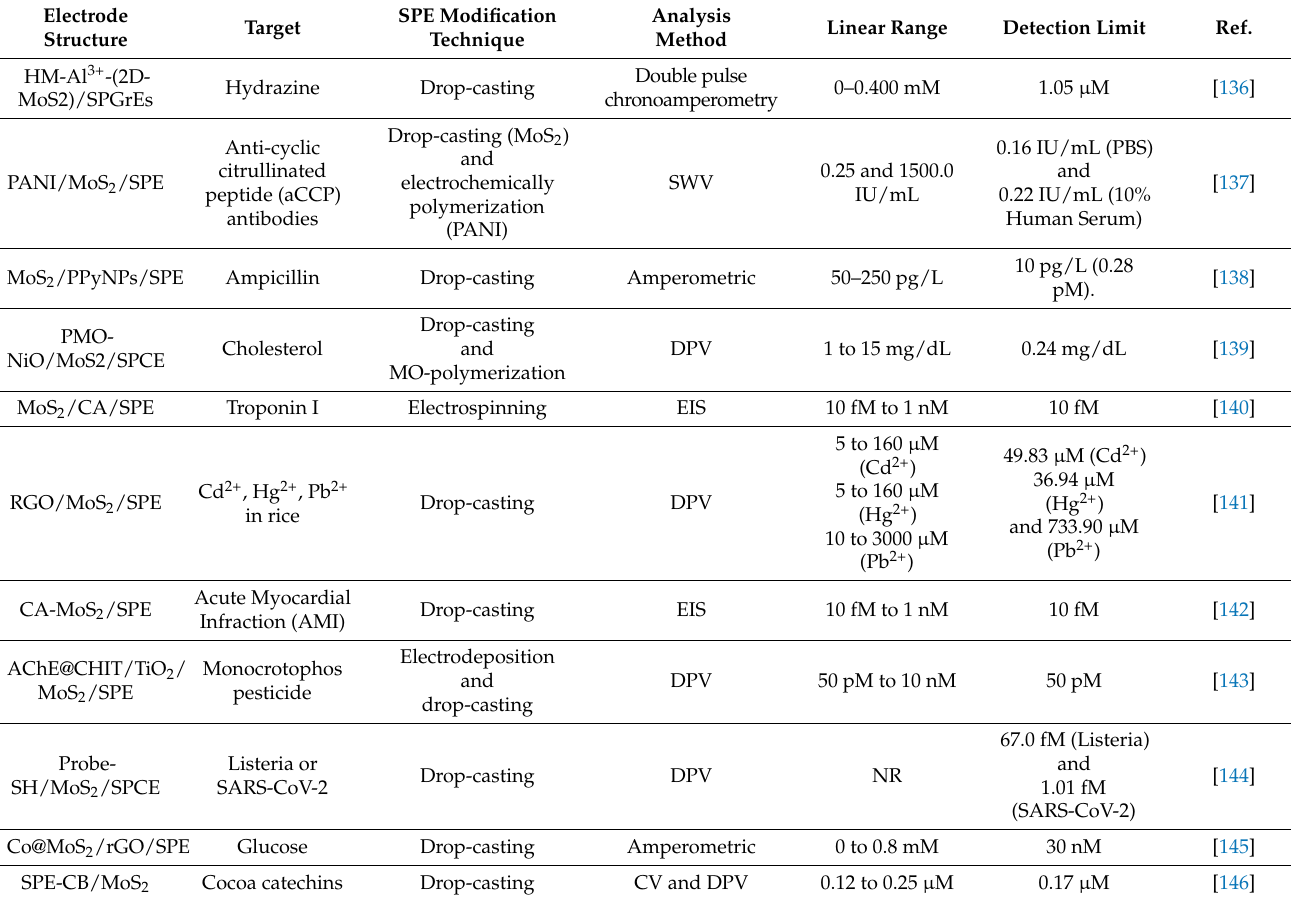
Table 2. MoS 2 material applications on printed electrochemical